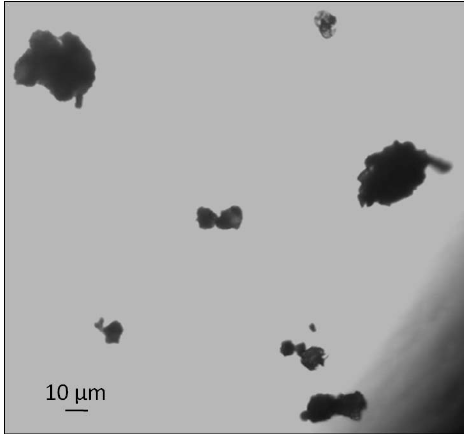
Fig. 1. Optical microscope image of synthesised silicate particles used in the acid solution-powder experiments.